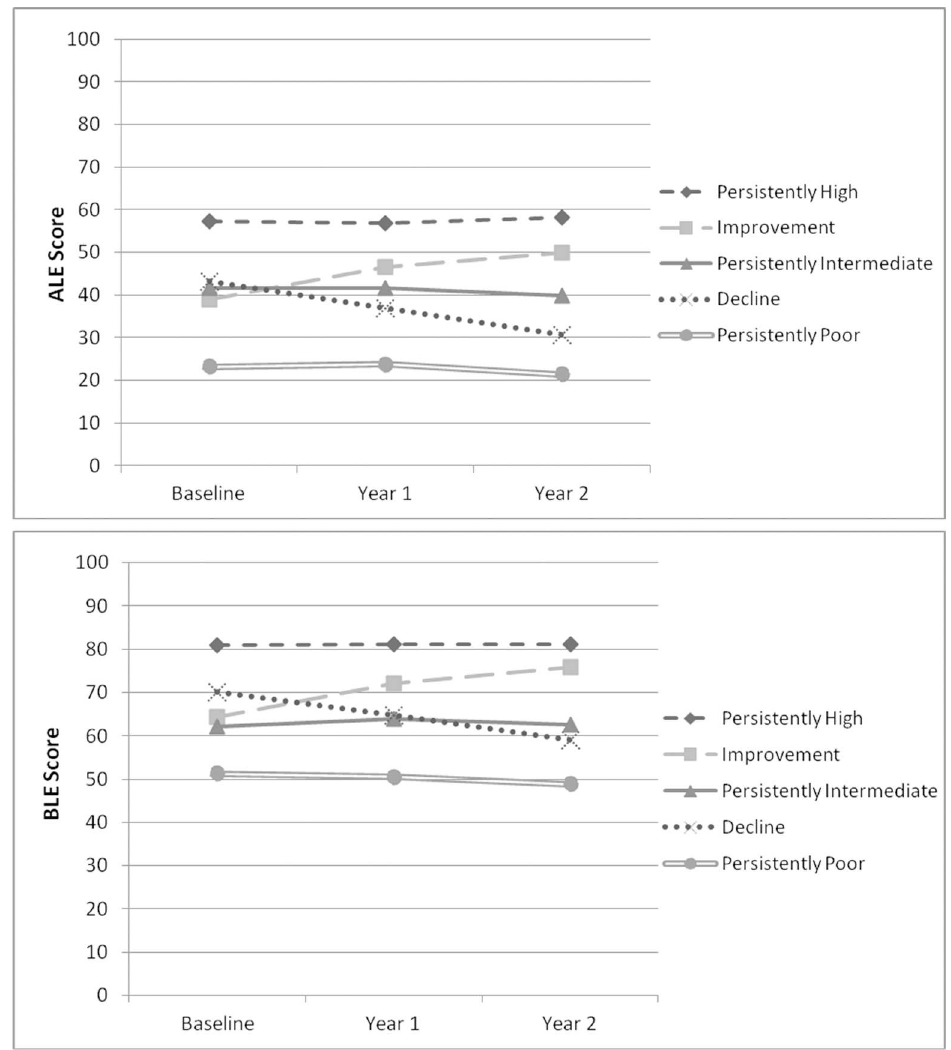
Fig 1. Mean mobility scores by ALE and BLE mobility trajectoryfrom baseline through year 2 (N = 391). ALE = AdvancedLower-Extremity Function; BLE = Basic Lower-Extremity Function. factor = 41.2), and 7 vs. 6 trajectories (log Bayes factor = 11.3), although the model with 7 tra- jectories did not converge.